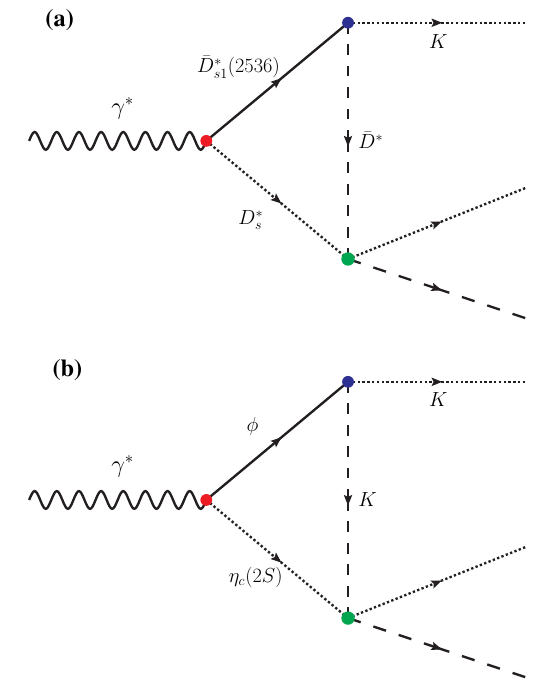
Fig. 5 Possible (a) D s 1 ( 2536 ) ¯ D ∗ s D ∗ 0 and (b) η c φ K triangle diagrams of e + e − → K + Z ∗ cs process with the generated Z ∗ cs (green circles) decaying to ¯ D ∗ s D 0 , J /ψ K or other possible channels. The green circles denote the T -matrix elements which include the effects of the generated Z ∗ cs state